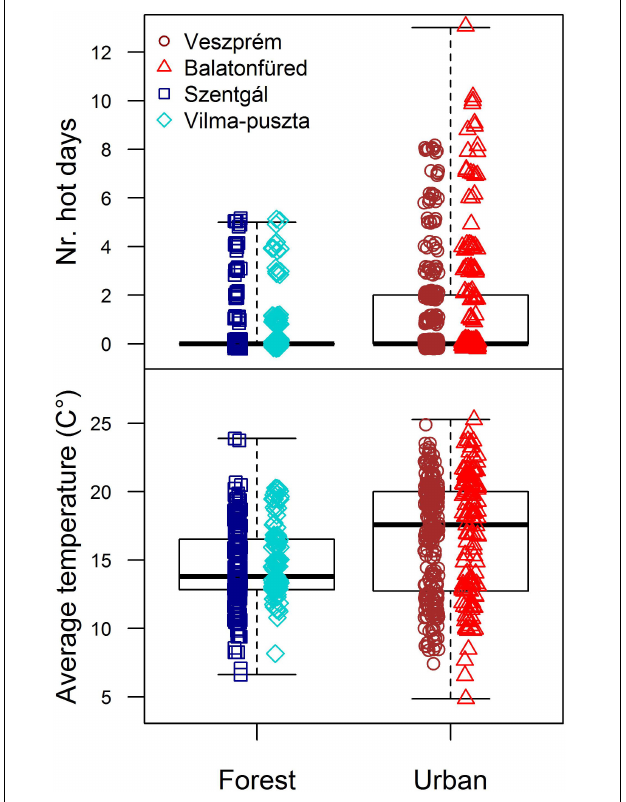
FIGURE 1 | Distribution of the number of hot days and average temperature during the nestling periods in our study sites. Boxes show the interquartile range, the thick line is the median, and whiskers refer to the range of data distribution. Data points represent great tit broods (blue: forest, red: urban).